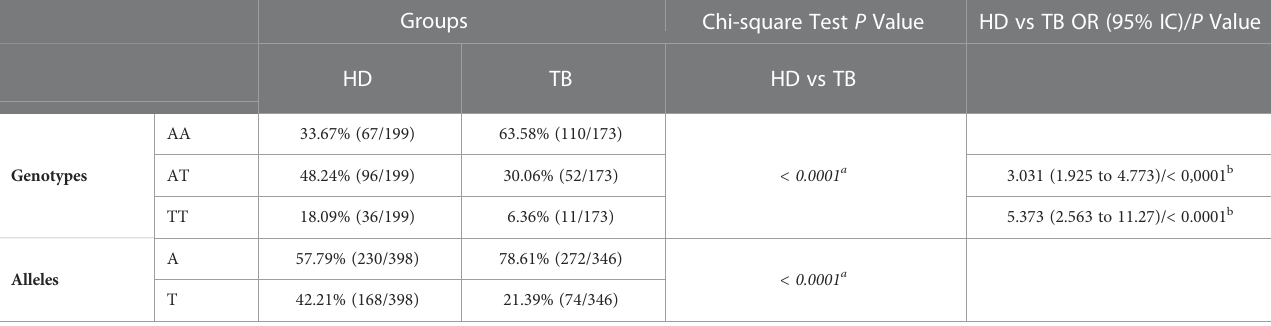
TABLE 2 Distribution of genotype and allele frequencies of IFN- g gene (+874 A/T) among patients with tuberculosis (TB) and Healthy Donors (HD). Categorical variables are expressed in